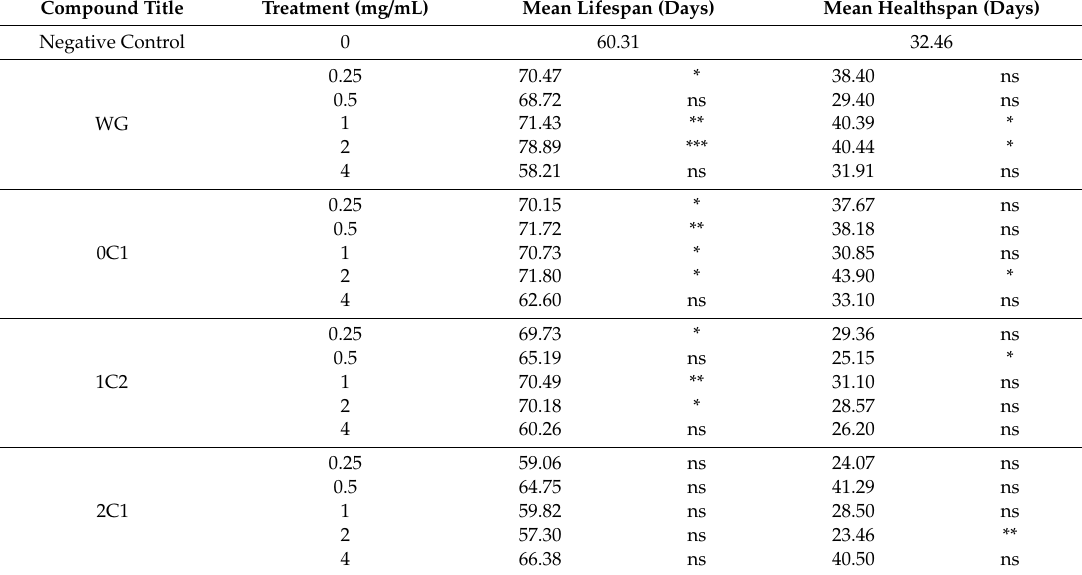
Figure 2. Survival curves of D. melanogaster fed with di ff erent concentrations of garlic (black and white) over time. A ) White garlic, B ) 0C1: black garlic with 13 days aging, C ) 1C2: black garlic with 32 days aging and D ) 2C1: black garlic with 45 days aging. Table 3. Mean and significances of lifespan and healthspan curves for the di ff erent garlic treatments assayed in D. melanogaster